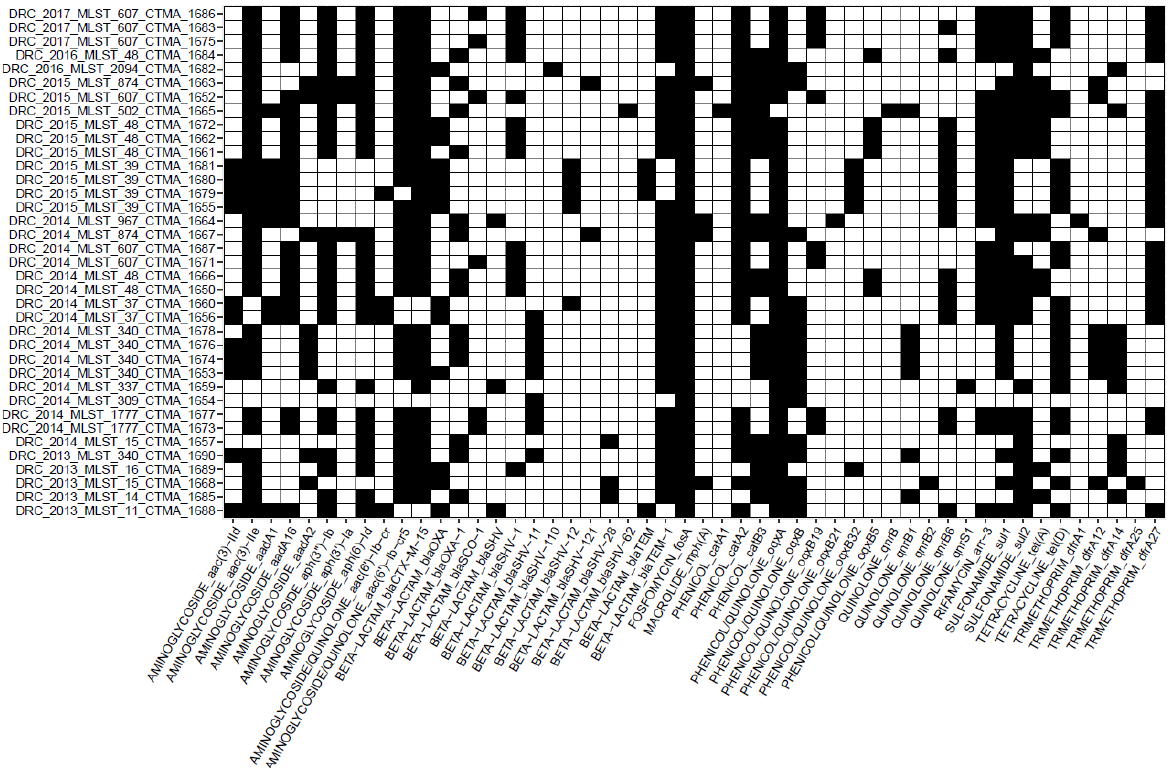
Figure 2. Heatmap of the genes involved in Antimicrobial Resistance (AMR) and identified with the AMRFinder tool. Black cells indicate the presence of the corresponding AMR gene.